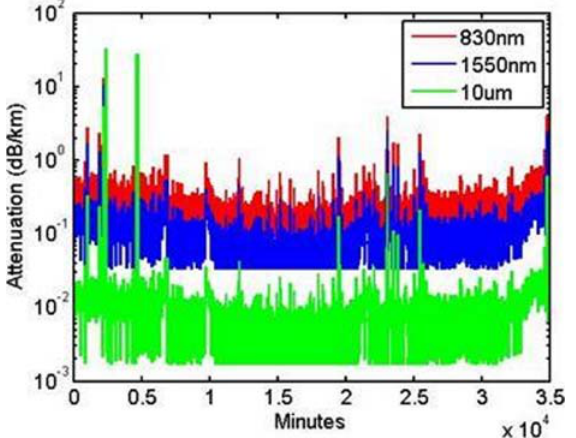
FIG. 12. TIME SERIES PLOT OF ESTIMATED SPECIFIC OPTICAL ATTENUATION BYKIM MODEL FOR THE YEAR 2012